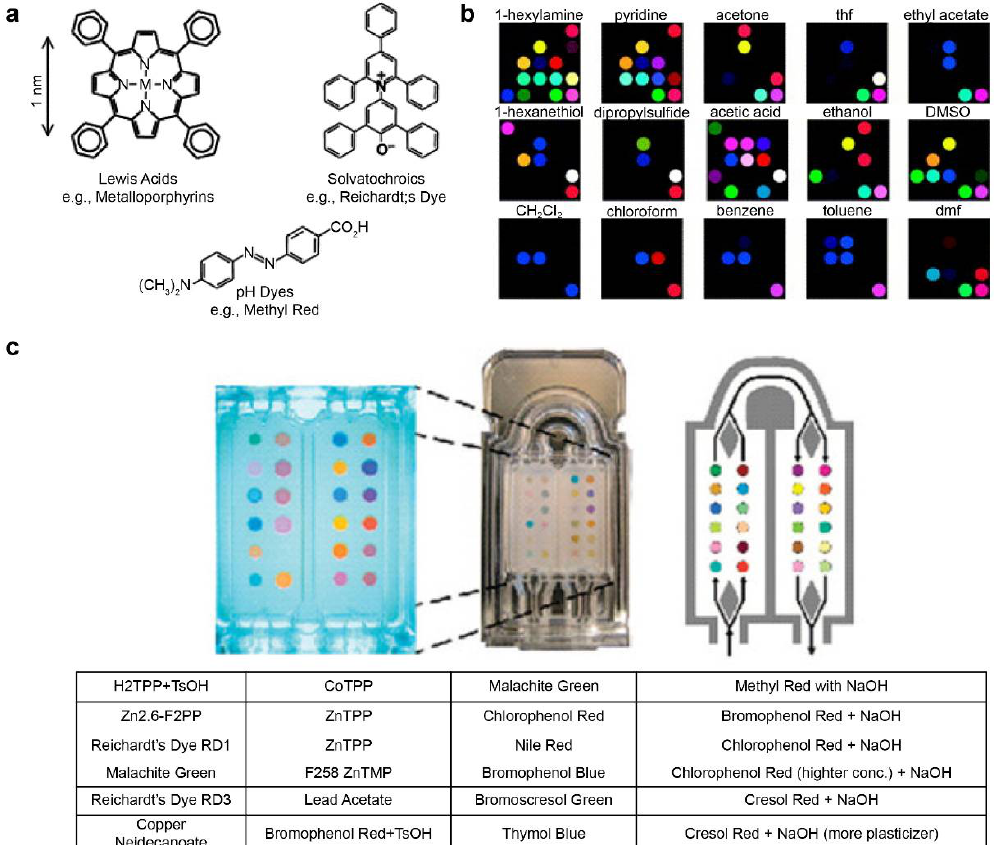
Figure 3. Metal-containing dye sensor array-type e-nose. ( a ) Suslick used strong chemical reactions such as “Lewis acid/base dyes (i.e., metal ion-containing dyes),” “Brønsted acidic or basic dyes (i.e., pH indicators),” and “dyes with large permanent dipoles (i.e., zwitterionic solvatochromic dyes).” Various types of sensor arrays were fabricated using the base dye ( b ) Electronic nose model that classifies various types of VOCs using the manufactured sensor array. ( c ) Exhalation analysis of lung cancer patients using the e-nose technology. The images ( a , b ) were adapted with permission from [130]. The image ( c ) was adapted with permission from [103].